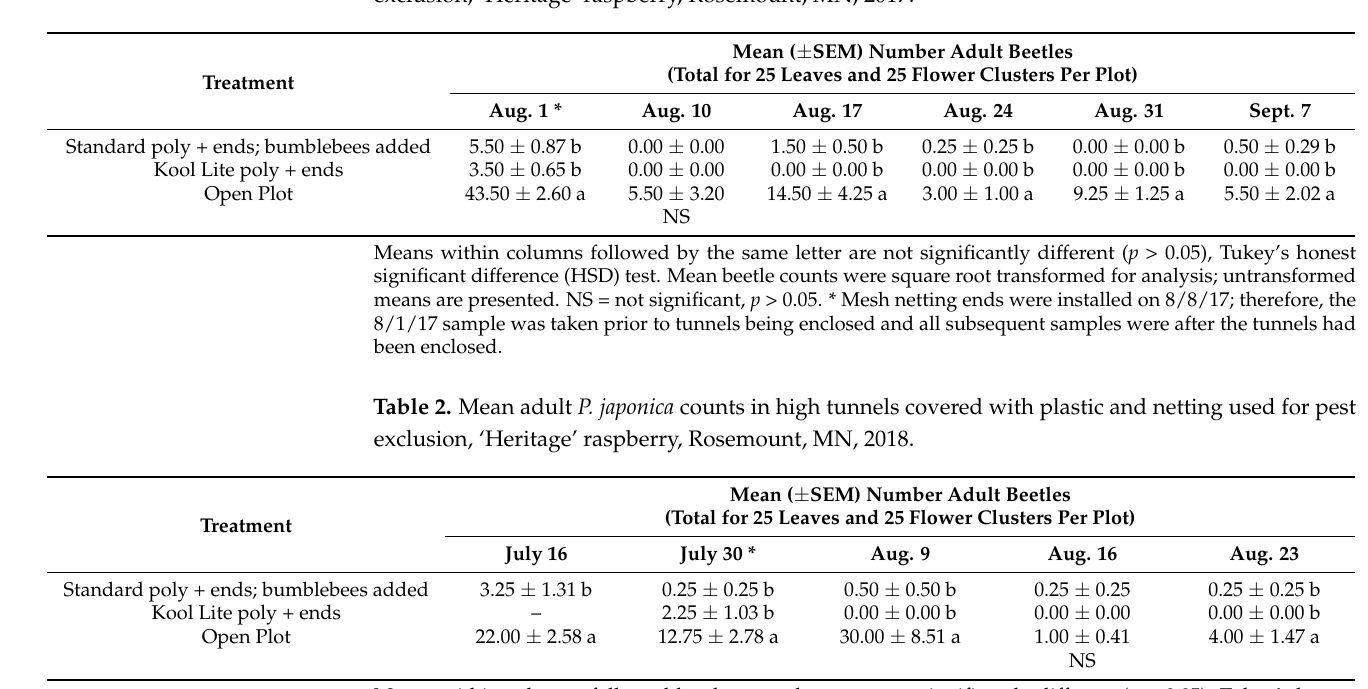
Table 1. Mean adult P. japonica counts in high tunnels covered with plastic and netting used for pest exclusion, ‘Heritage’ raspberry, Rosemount, MN, 2017.